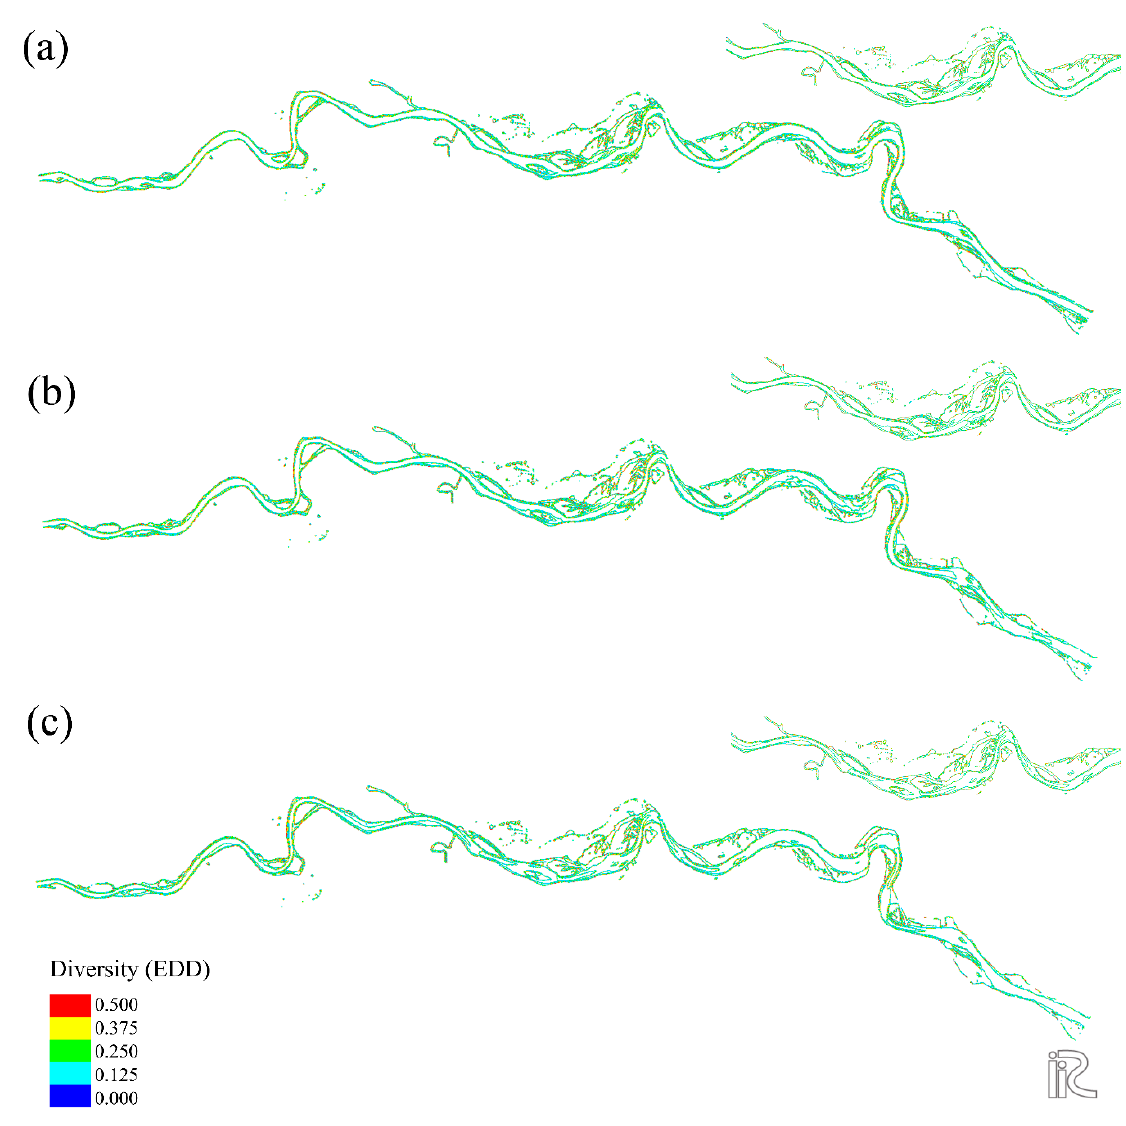
Figure 4. Simulated Eco-Environmental Diversity index for the ( a ) maximum, ( b ) mean and ( c ) minimum discharge.